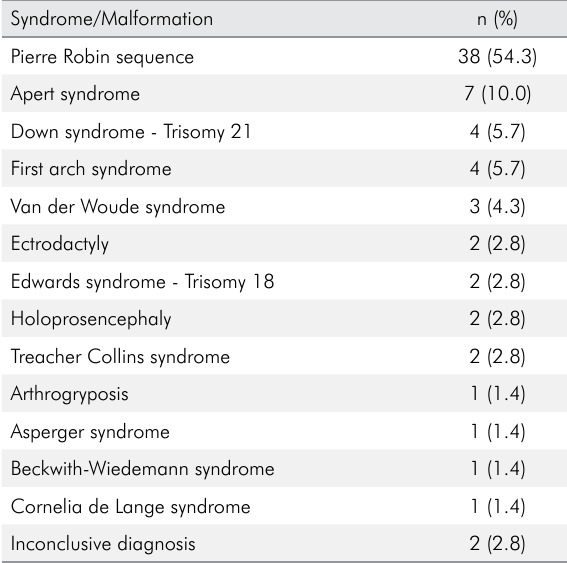
Table 2. Frequency of syndromes and other malformations (n= 70).